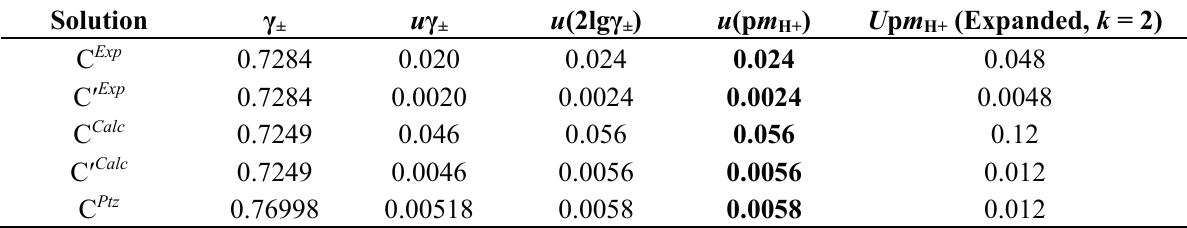
Table 2. Uncertainty introduced by γ ± to the calculation of p m H+ for acidic solutions in seawater background, function of its uncertainty